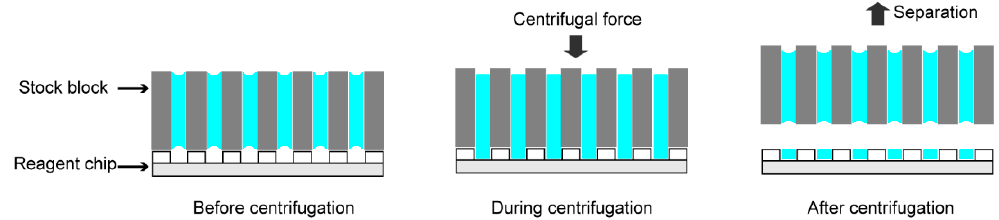
Figure 4. Liquid dispensing by centrifugation. Before centrifugation, the reagents are retained within the reagent holes of the stock block due to the capillary action. During centrifugation, the reagents are spun down into the microwells due to the centrifugal force and the excess air in the microwells is expelled out. After centrifugation, the stock block is taken out from the fixture and nanoliter-volume reagents are dispensed into the microwells.